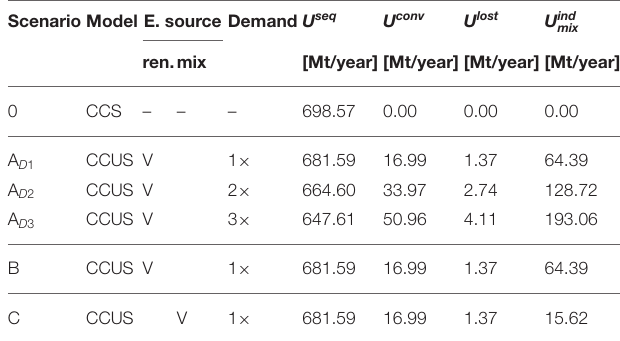
TABLE 5 | Main assumptions and results for Scenario 0, Scenario A, Scenario B, and Scenario